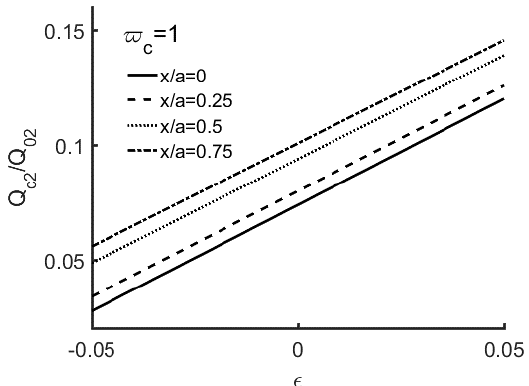
Figure 3. 𝑄 𝑐2 /𝑄 02 versus 𝜀 with 𝜛 𝑐 = 1 and 𝑥/𝑎 = 0, 0.25, 0.5, 0.75. Figure 3. Q c 2 / Q 02 versus ε with (cid:118) c = 1 and x / a